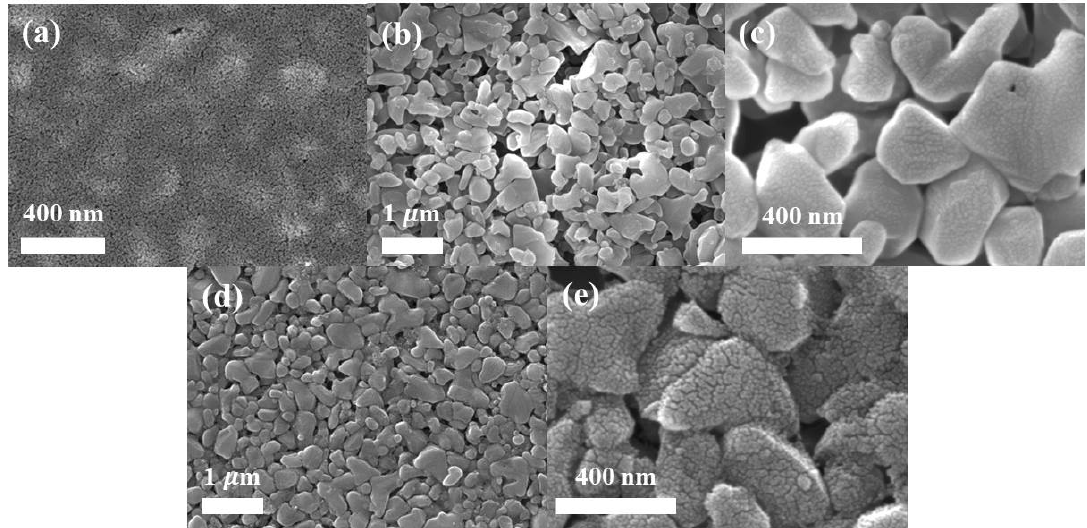
Figure 2. Surface scanning electron microscopy (SEM) image of a ( a ) Poly(oxyethylene methacrylate) (POEM)-directed TiO 2 film on FTO glass; ( b , c ) the bare Al 2 O 3 membrane; and ( d , e ) the POEM-directed TiO 2 film on the Al 2 O 3 membrane.